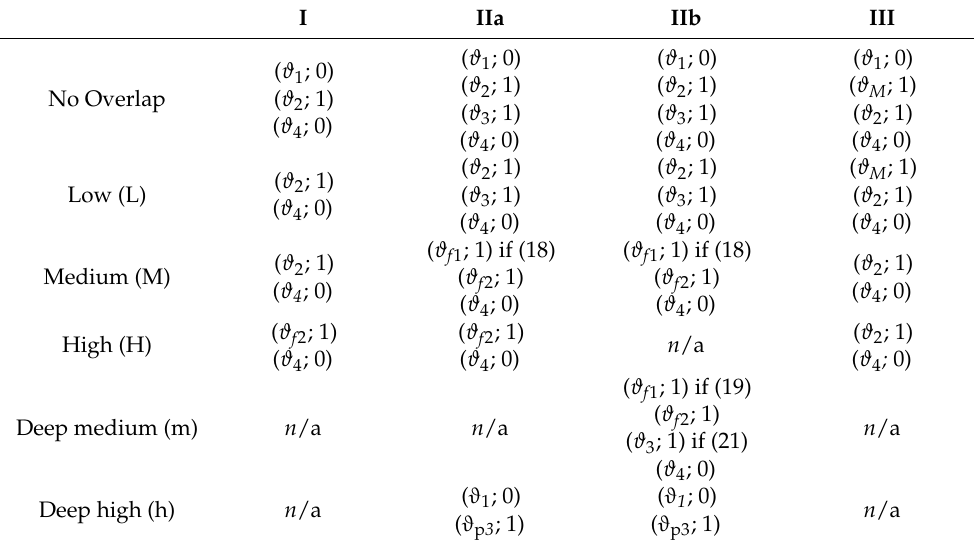
Table 4. Multiple flutes F shape key points for one period ( ϑ 4 − φ z ; ϑ 4 ) in